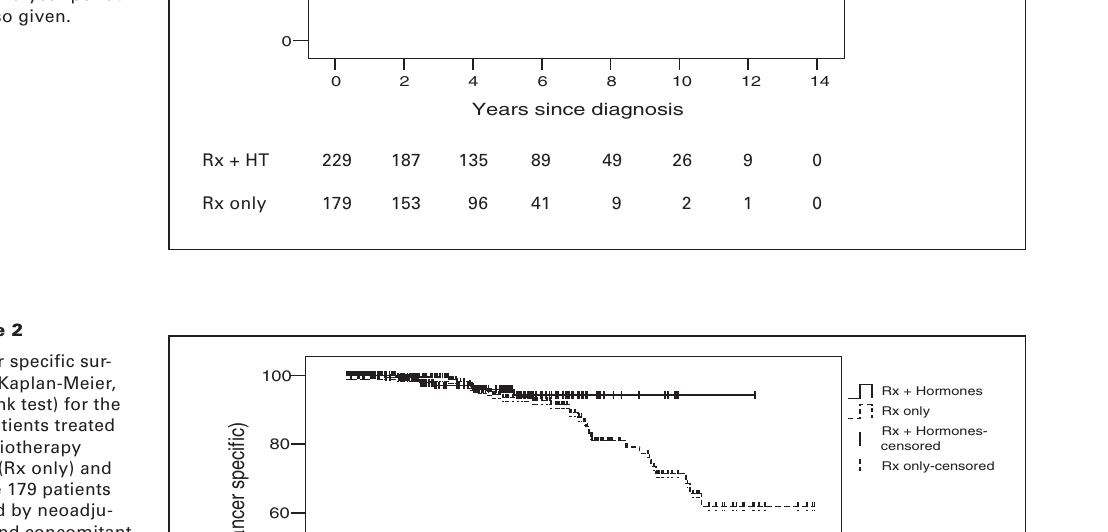
Overall survival (Ka- plan-Meier, log-rank test) for the 229 pa- tients treated by radiotherapy alone (Rx only) and for the 179 patients treated by neoadjuvant and concomitant andro- gen deprivation plus radiotherapy (Rx and Hormones). Patients at risk at the start of each two-year period are also given.